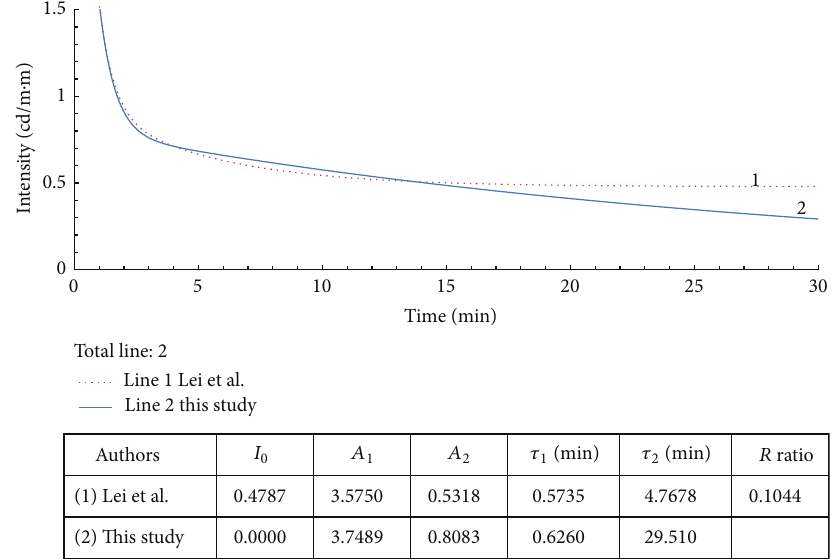
Figure 8: Example 5 with modified data from